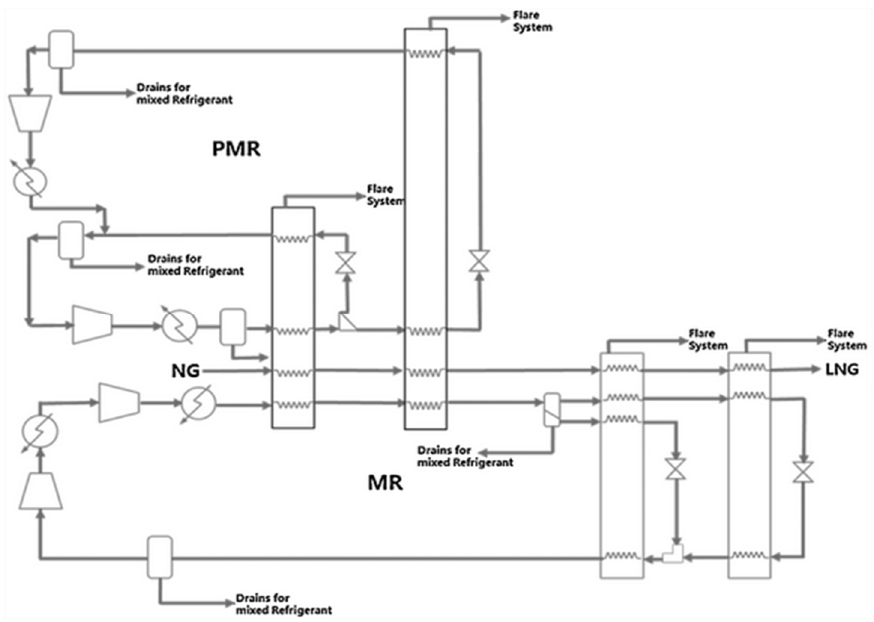
Figure 39. DMR-FLNG natural gas liquefaction process [153]. Reproduced with permission from Elsevier (license number